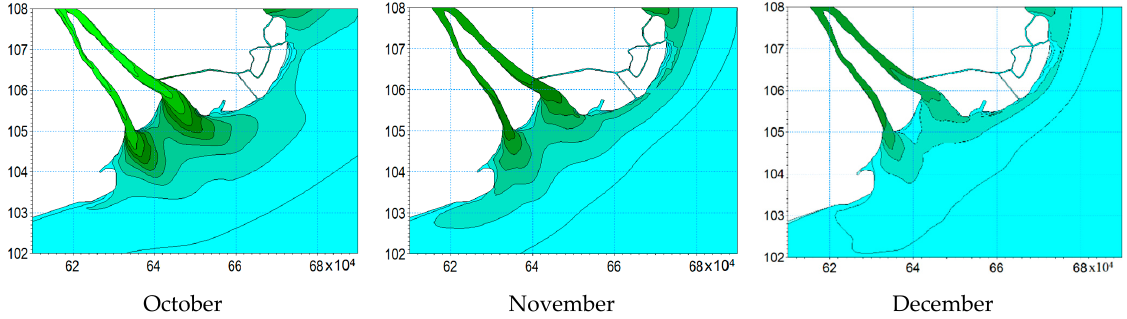
Figure 18. Spatial distribution of monthly mean SSC in the surface layer. Color scale is the same as in Figure 8.